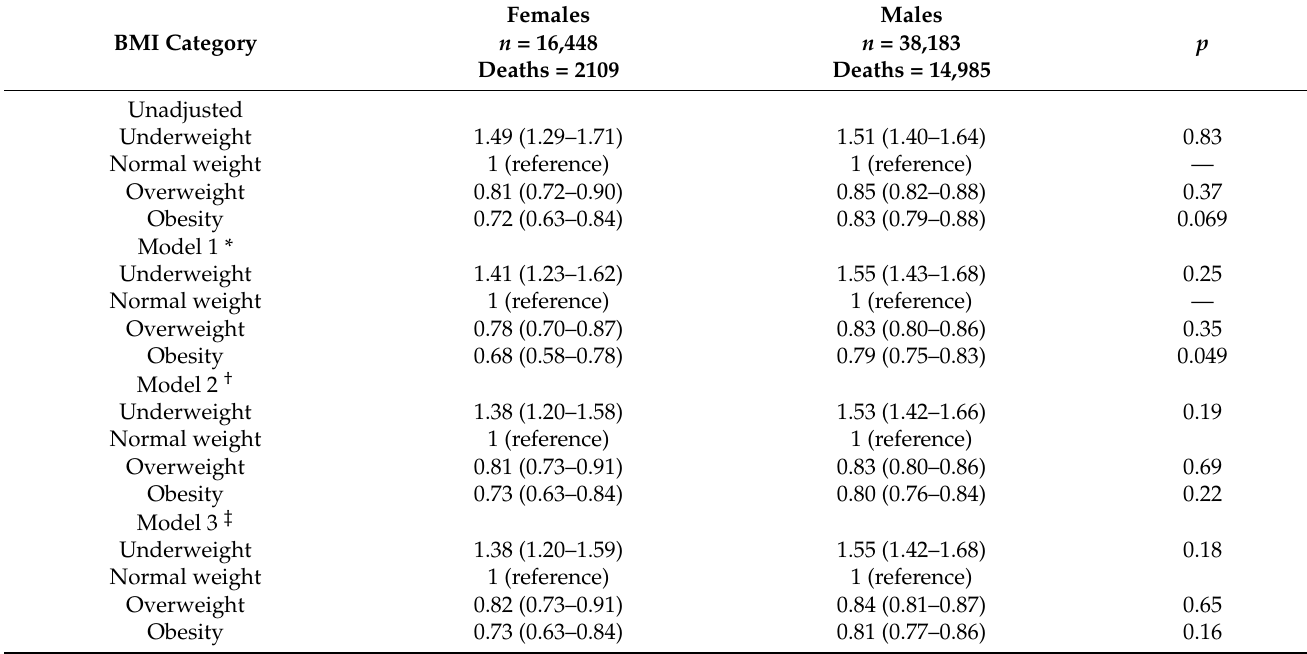
Table 3. Association of body mass index categories with survival stratified by sex. Results are hazard rations with 95% confidence intervals. p values compare the hazard ratios (interaction tests).